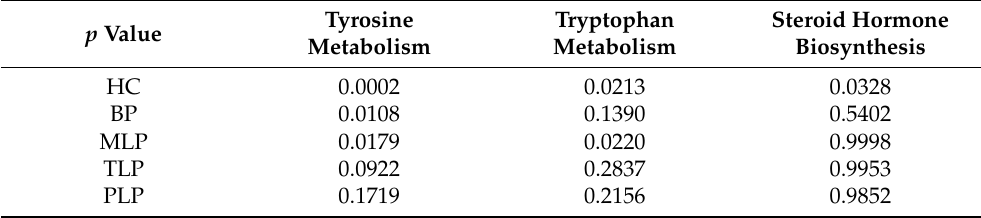
Table 2. Significant differences analysis of three metabolic pathways between the NC group and the other five